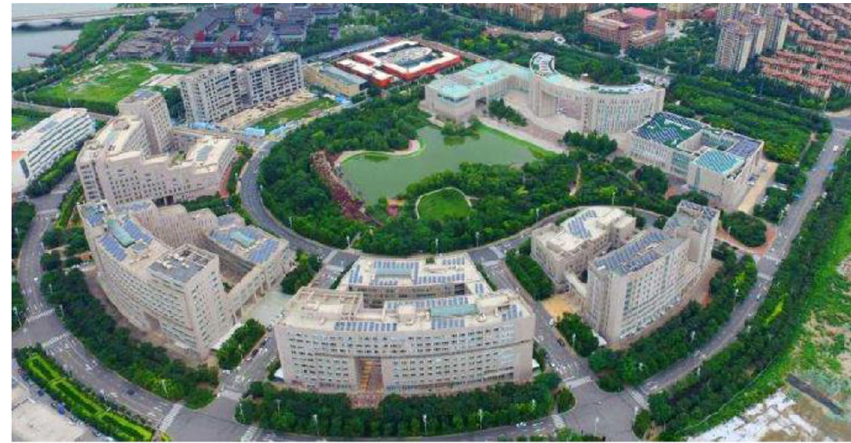
Fig. 25 Sino-Singapore Tianjin